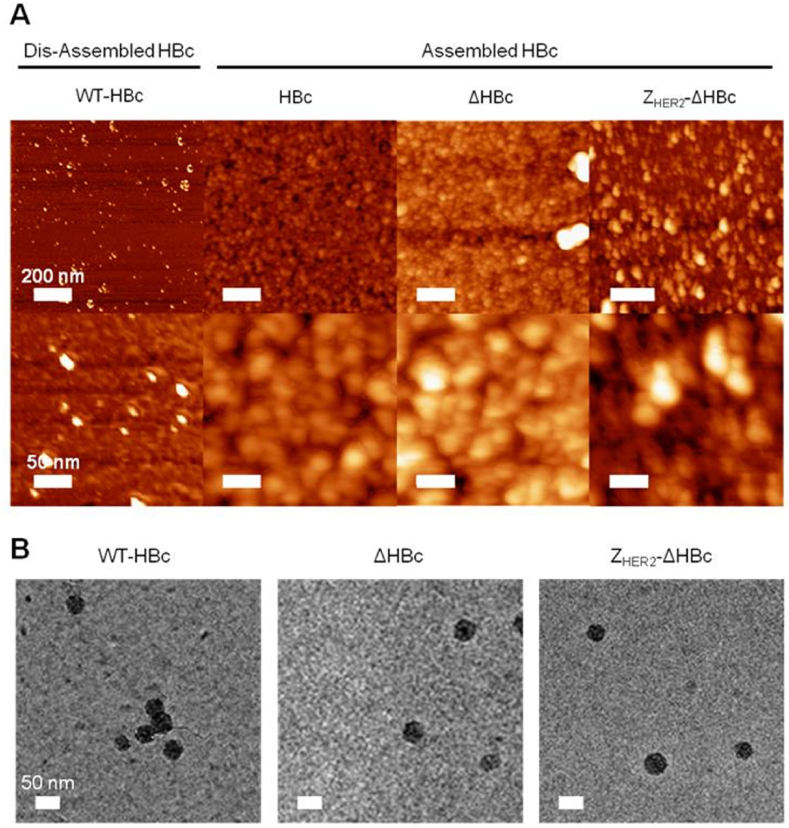
Morphological analysis of purified HBc core particles with Atomic Force Microscopy (AFM) and Cryo-Transmission Electron Microscopy (Cryo-TEM). (A) AFM images using tapping mode AFM (TM-AFM) and (B) cryo-EM images of HBc particles. Dis-assembled HBc were achieved by dilution in distilled water at 40 °C for 10 min. In A, HBc particles were deposited on the mica substrates and measurements were carried out in air at 25 °C using a Bruker Dimension ICON with Scan Assist. In B, 3 μL of 10 mg/mL assembled HBc particles solution was applied on hydrophilic TEM Quantifoil grids and plunged into the liquid ethane pool to produce a thin vitreous ice layer. Cryo-TEM images were acquired using a FEI Tecnai Spirit operated at 120 kV using a Gatan 626 cryo-transfer tomography holder. Dis-assembled HBc appeared as irregular structures while assembled HBc (WT-HBc, ΔHBc, and ZHER2-ΔHBc) particles appeared spherical in shape.